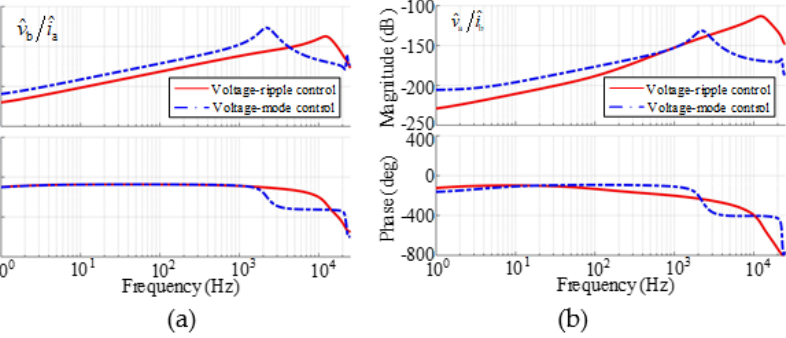
Figure 7. Bode plots of cross-regulation transfer functions under voltage mode-controlled and volt- ripple-controlled PCCM SIDO buck converters: ( a ) ˆ v b /ˆ i a ; ( b ) ˆ v a /ˆ i b